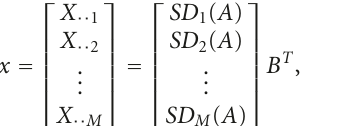
is proportional to the electric field component along that dipole. There are orthogonal short dipoles, the x - and y -axis dipoles, parallel to the x - and y -axes, respectively. The m th dipole pair, m = 1,2, ... , M , has its center on the y -axis at y = ( m − 1) d . The distance d between two adjacent dipole pairs is assumed to be a half-wavelength to avoid angle ambi- guity problems. We consider signals in the far-field, in which case the signal sources are far enough away that the arriving waves are essentially planes over the length of the array. As- sume that the noise is independent of the source, and noise is additive i.i.d.